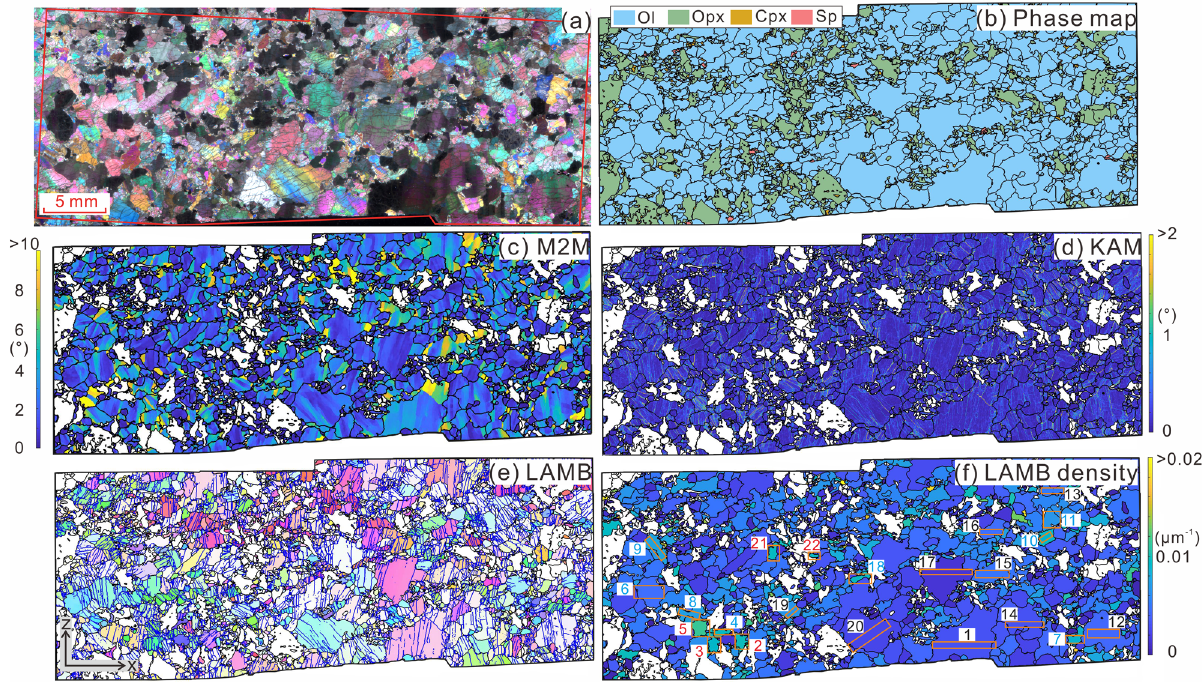
Figure 1. Microstructures of the studied harzburgite sample. ( a ) Cross-polarized image showing a porphyroclastic texture and extensive undulose extinctions and subgrains in olivine. ( b ) EBSD phase map showing the modal composition. ( c ) M2M map showing intracrystalline lattice distortions in olivine. Distributions of ( d ) KAM, ( e ) LAMBs (blue lines) and ( f ) LAMB density (ρ LAMB , see Results Section for its definition) are shown for olivine grains. EBSD data were collected using the step size of 15 μm. In ( f ), the numbered boxes denote the analyzed domains of the 22 olivine grains, and colors of the text correspond to the three groups of olivine classified by LAMB